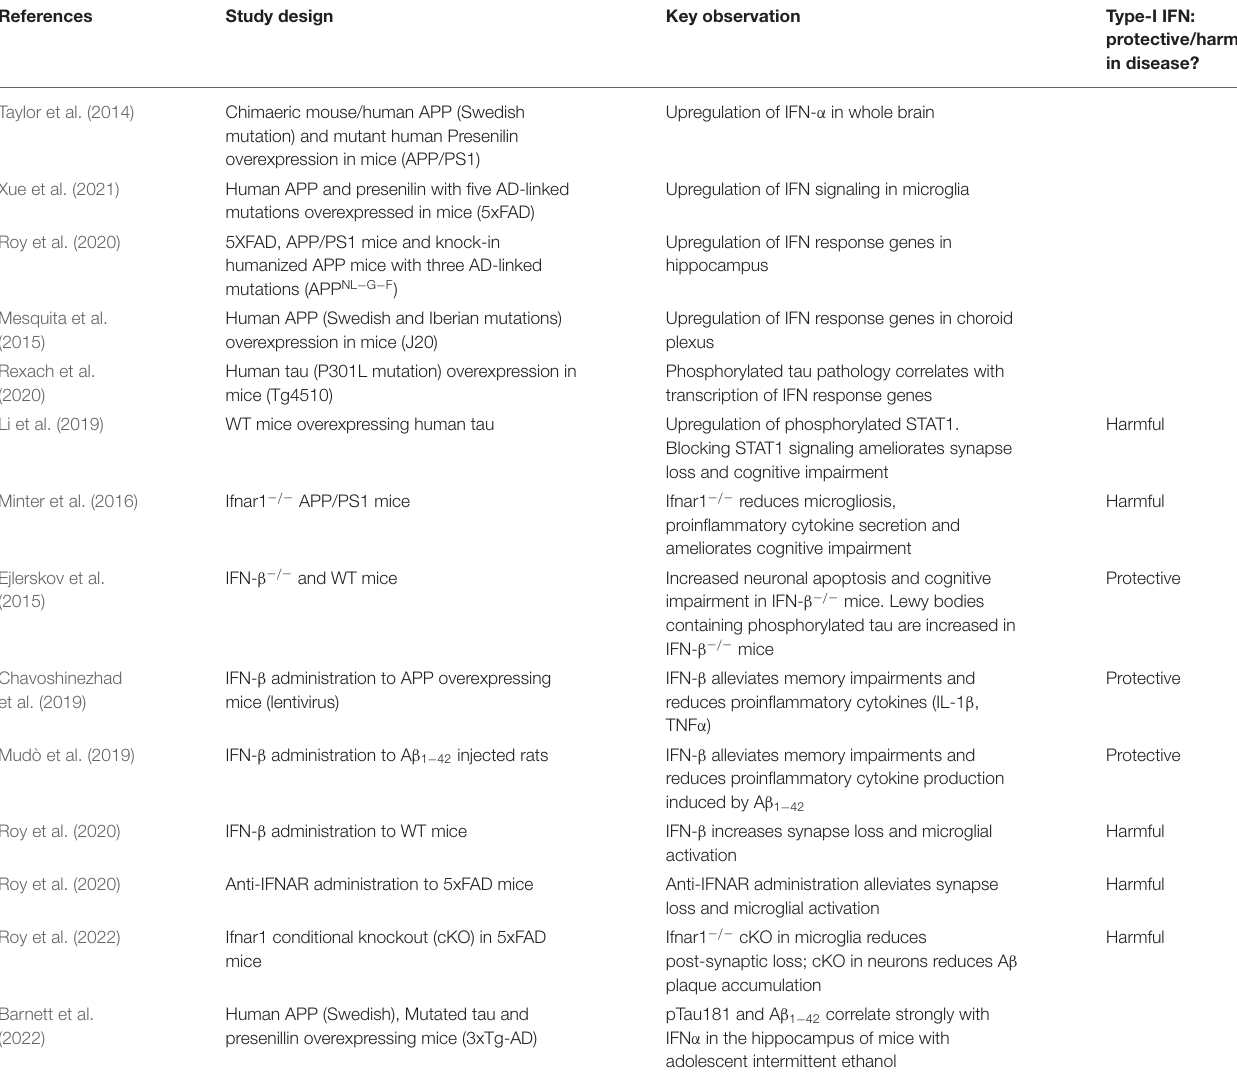
TABLE 2 | Summary of studies evaluating type-I IFNs in in vivo models of AD and